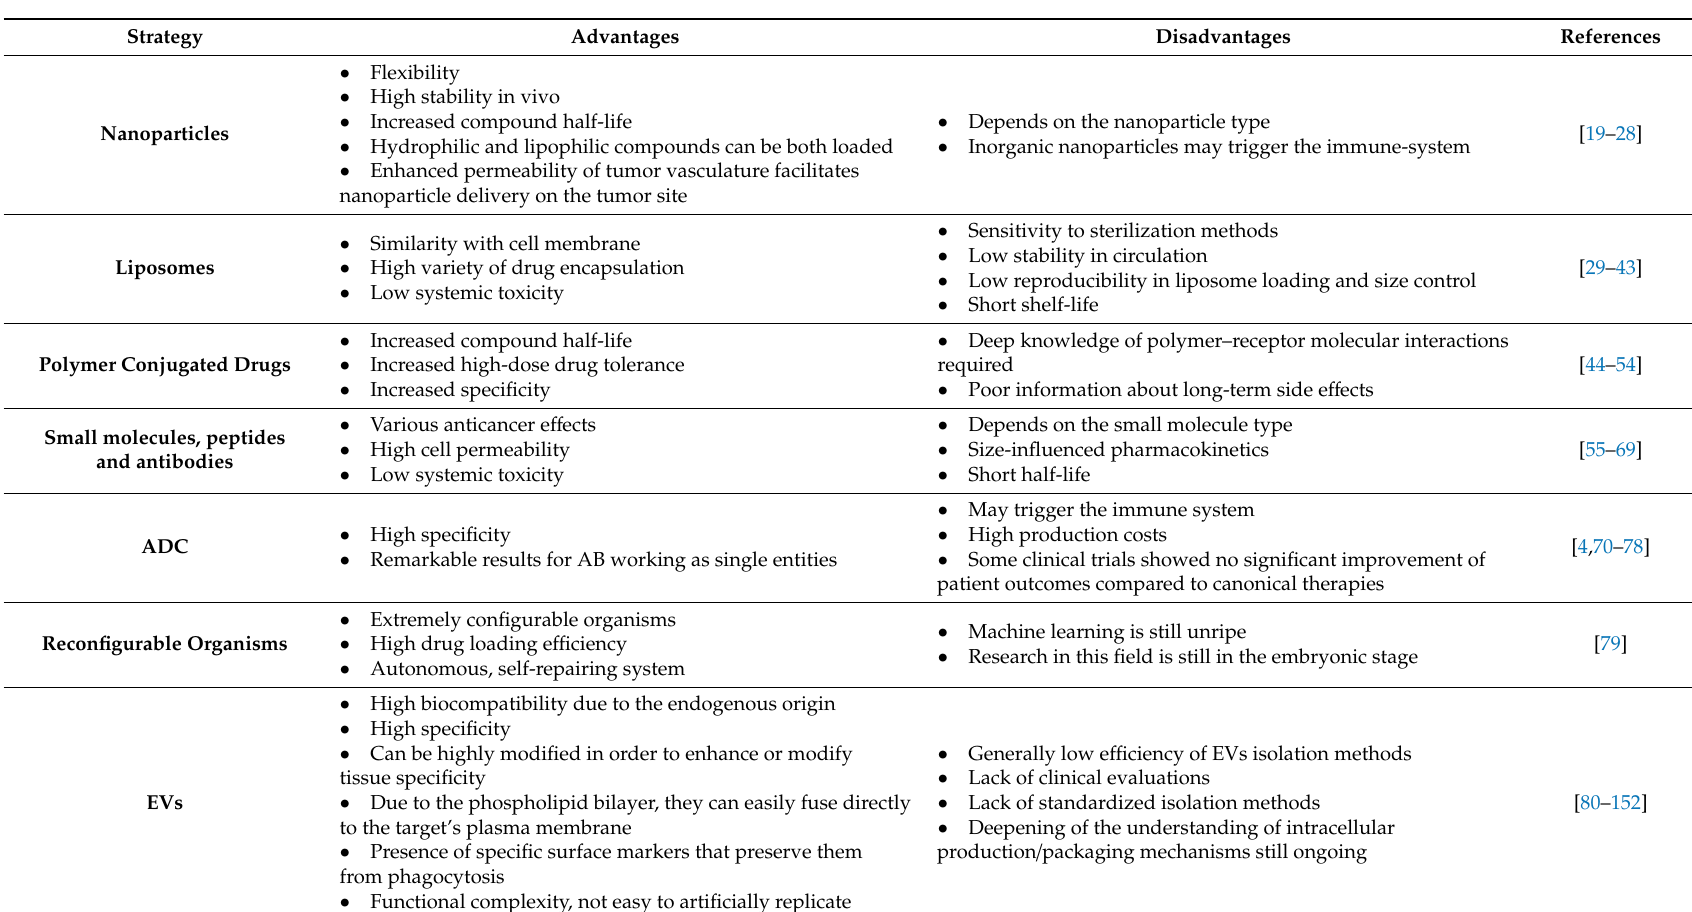
Table 1. The advantages and disadvantages of main drug delivery approaches. Abbreviations: ADC, antibody-drug conjugated; EVs, extracellular